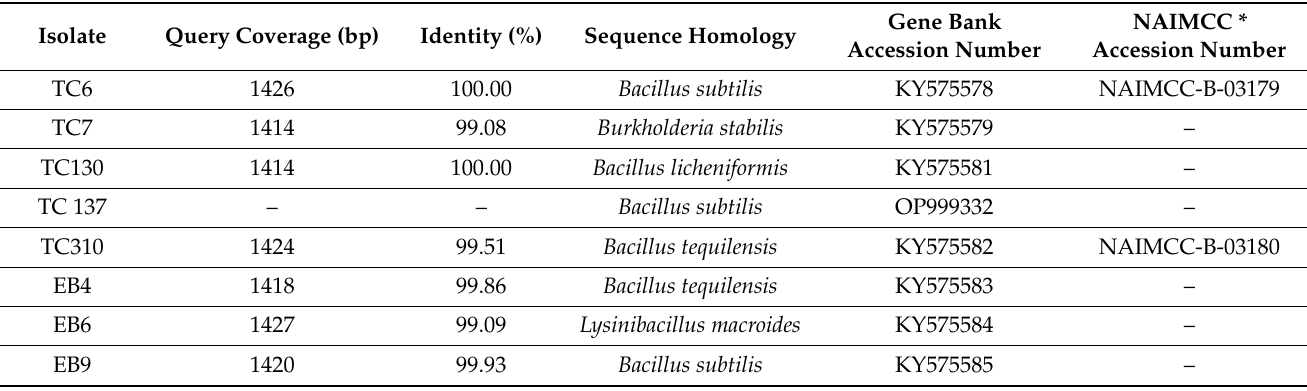
Figure 1. In vivo evaluation of endophytes against bacterial blight in pomegranate cv. Bhagawa in terms of ( a ) disease incidence and ( b ) disease severity. Pomegranate plants were inoculated with pathogen ( Xap ) and endophytes in the following ways: Set-I, Xap and endophytes culture broths were sprayed at the same time; Set-II, Xap was sprayed 8 days earlier than endophytes; Set-III, endophyte culture broths were sprayed 8 days earlier than the Xap . Control plants were challenged only with Xap . Error bars are based on the standard error. Table 3. Identification of promising bacterial endophytes by 16S rDNA sequence